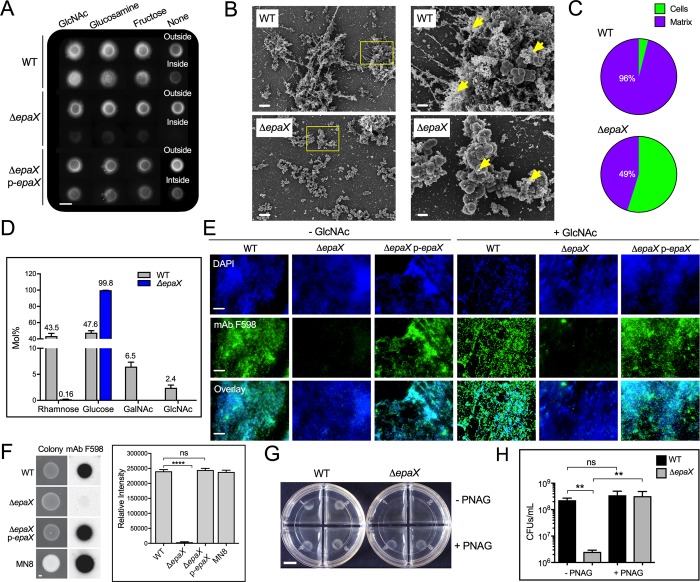
EpaX is necessary for E. faecalis semisolid surface penetration and synthesis of polyGlcNAc-containing polysaccharides.(A—H) Penetration analysis for E. faecalis VE14089 (closely-related to MMH594) and the EpaX-deficient mutant (ΔepaX) (A) Invasion was tested for mutant and its parental strain with (right panel) or without exogenous GlcNAc, glucosamine or fructose. Complementation in-trans of epaX WT allele restored invasion (p-epaX). Scale bar: 6,000 μm. (B) SEM images of external cells at (left) low magnification (scale bar: 5 μm). Yellow squared areas were imaged at higher magnifications (right; scale bar: 1 μm), where extracellular matrix is indicated (yellow arrow head). (C) Fractions of cells and extracellular matrix found on the visible surface of SEM images of non-penetrating WT and mutant strains. (mean±SE; n = 3; *P<0.05; two-tailed unpaired t–test) (D) Glycosyl composition of polysaccharides extracted from liquid cultures of WT and ΔepaX grown to exponential phase in MOLP broth (mean±SE; n = 3). (E) Fluorescence microscopy images of external cells from MOLP-grown colonies incubated with mAb F598 to visualize GlcNAc-containing exopolysaccharides (green fluorescence). DAPI was used to stain bacterial DNA (blue fluorescence). Scale bar: 20 μm. (F) Immunoblot (left panel) of 24-hour-grown colonies. The relative intensity obtained upon incubation with mAb F598 was calculated for each colony using Image J, right panel; (mean±SE; n = 8; ****P<0.0001 for both one-way ANOVA and Turkey’s multiple comparison test). Scale bar: 1000 μm. (G) Semisolid media penetration of WT and ΔepaX grown with and without 200 μM PNAG purified from S. aureus MN8. Scale bar: 5,000 μm. (H) Quantification of invasion was expressed as CFUs/mL (mean±SE; n = 4; **P<0.01 for both the one-way ANOVA and Tukey’s multiple comparison test).